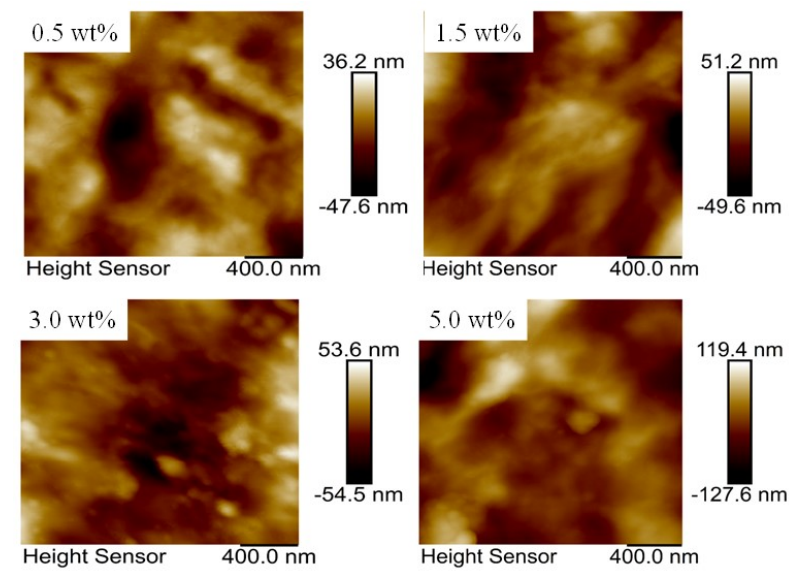
Figure 4. AFM images of the composite films with the mass content of graphene of 0.5 wt%, 1.5 wt%, 3.0 wt%, and 5.0 wt%, respectively.